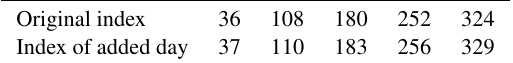
Table B1. Indices where extra days are added per